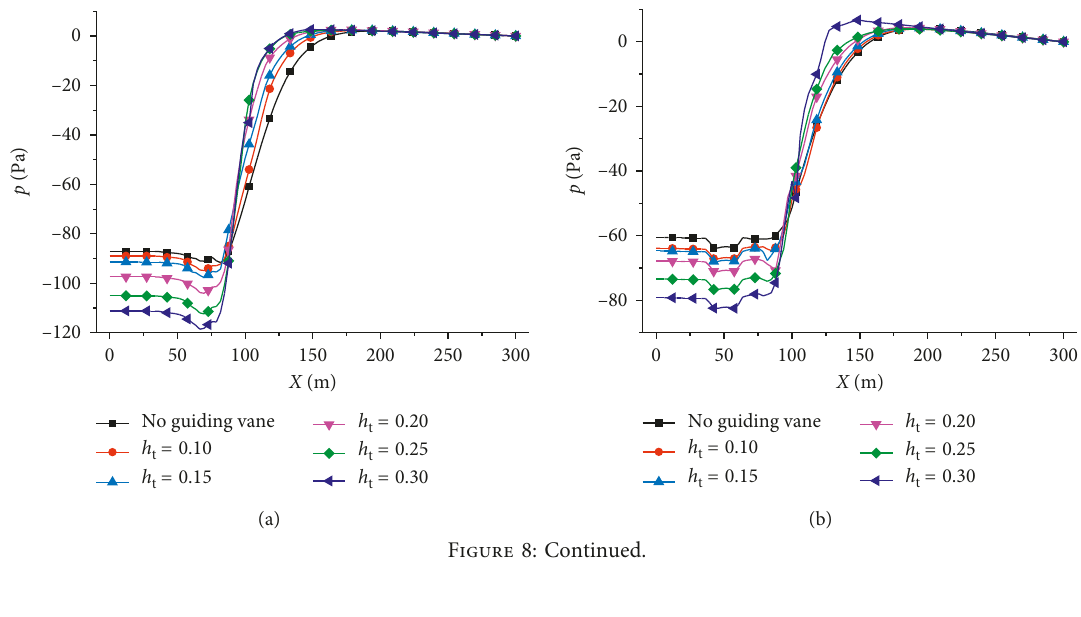
u 1m/s. (b) u 2m/s. (c) u (cid:31) (cid:31) (cid:31)